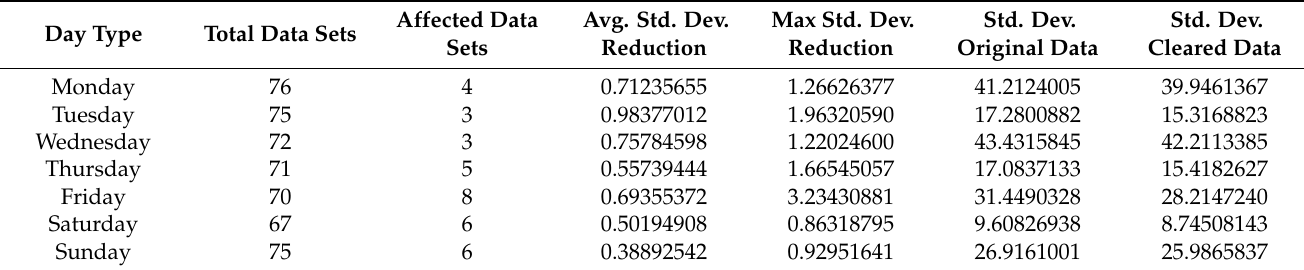
Table 16. Semester I baseline for original and cleared data sets.